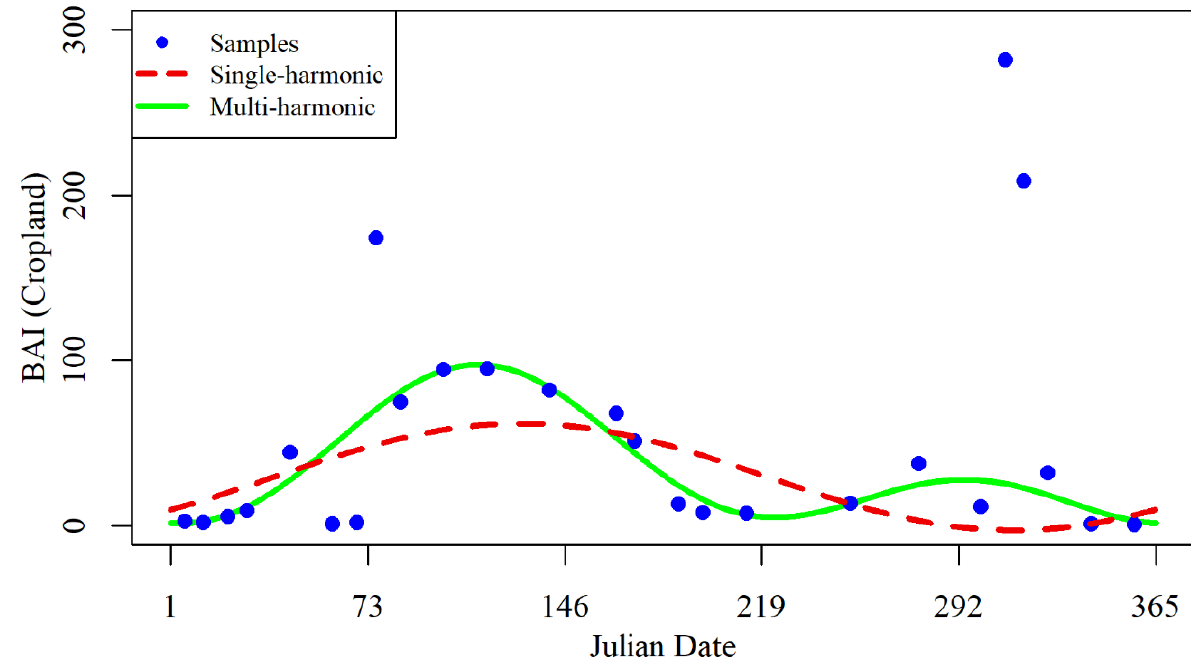
Figure 3. Comparison of cropland pixel time series fitting results with BAI values from the single-harmonic model and multi-harmonic model, respectively.